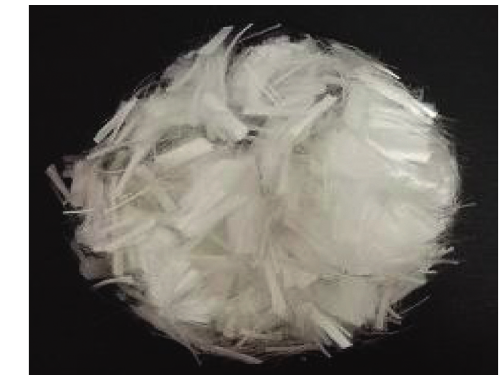
Figure 2: PP fiber.